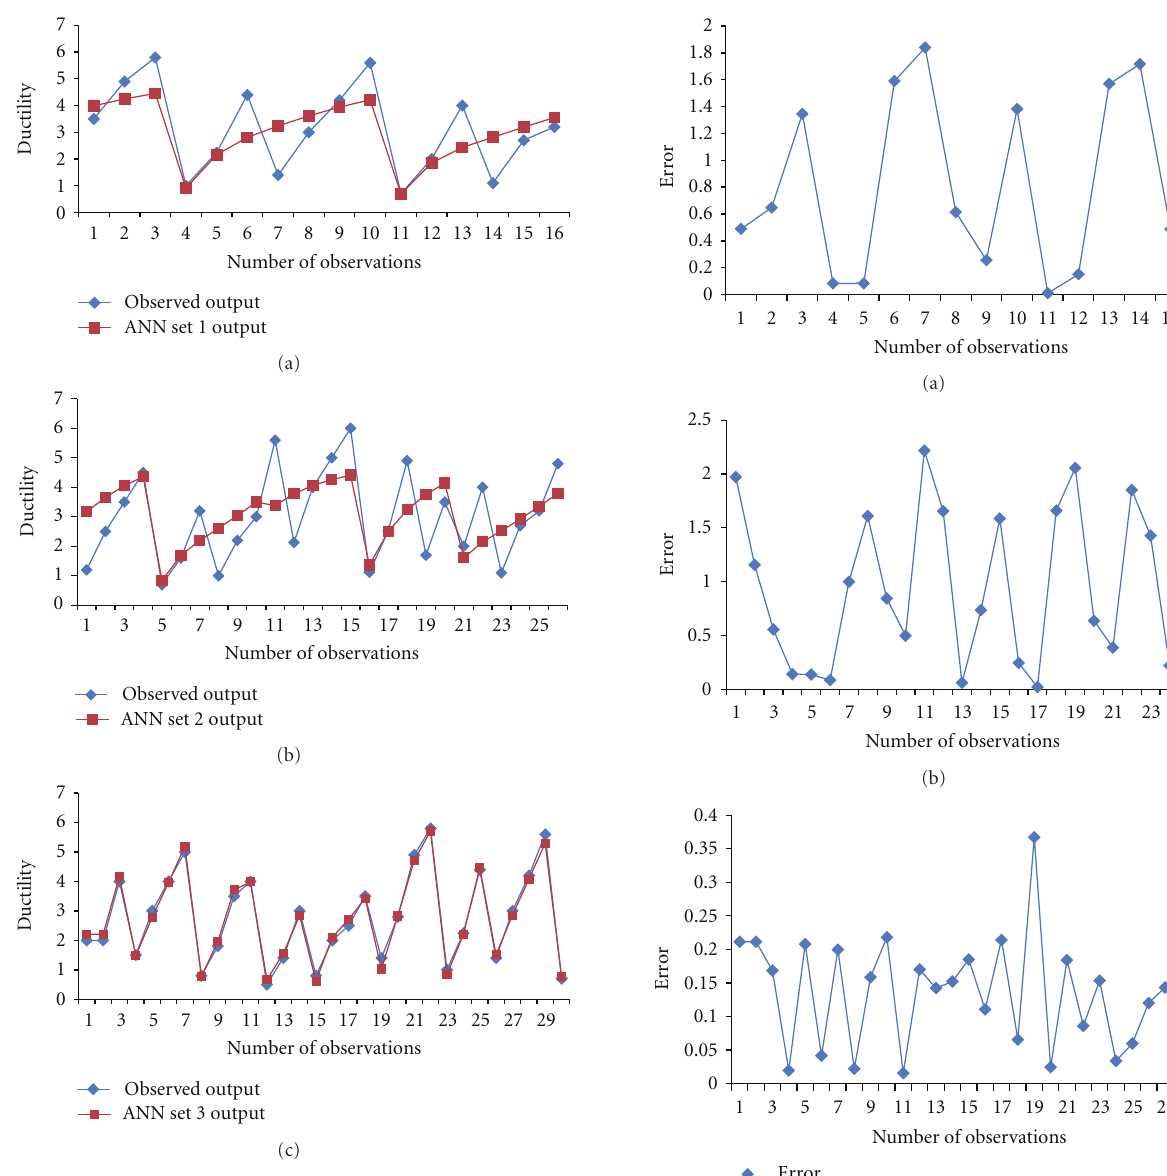
the optimized parameters and it is found to be with data set 3. In Figures 5(a), 5(b), and 5(c) maximum error with individual dataset is presented, which is 0.36 for data set 3; 1.8 for data set 1; 2.2 for data set 2. It is purely due to the